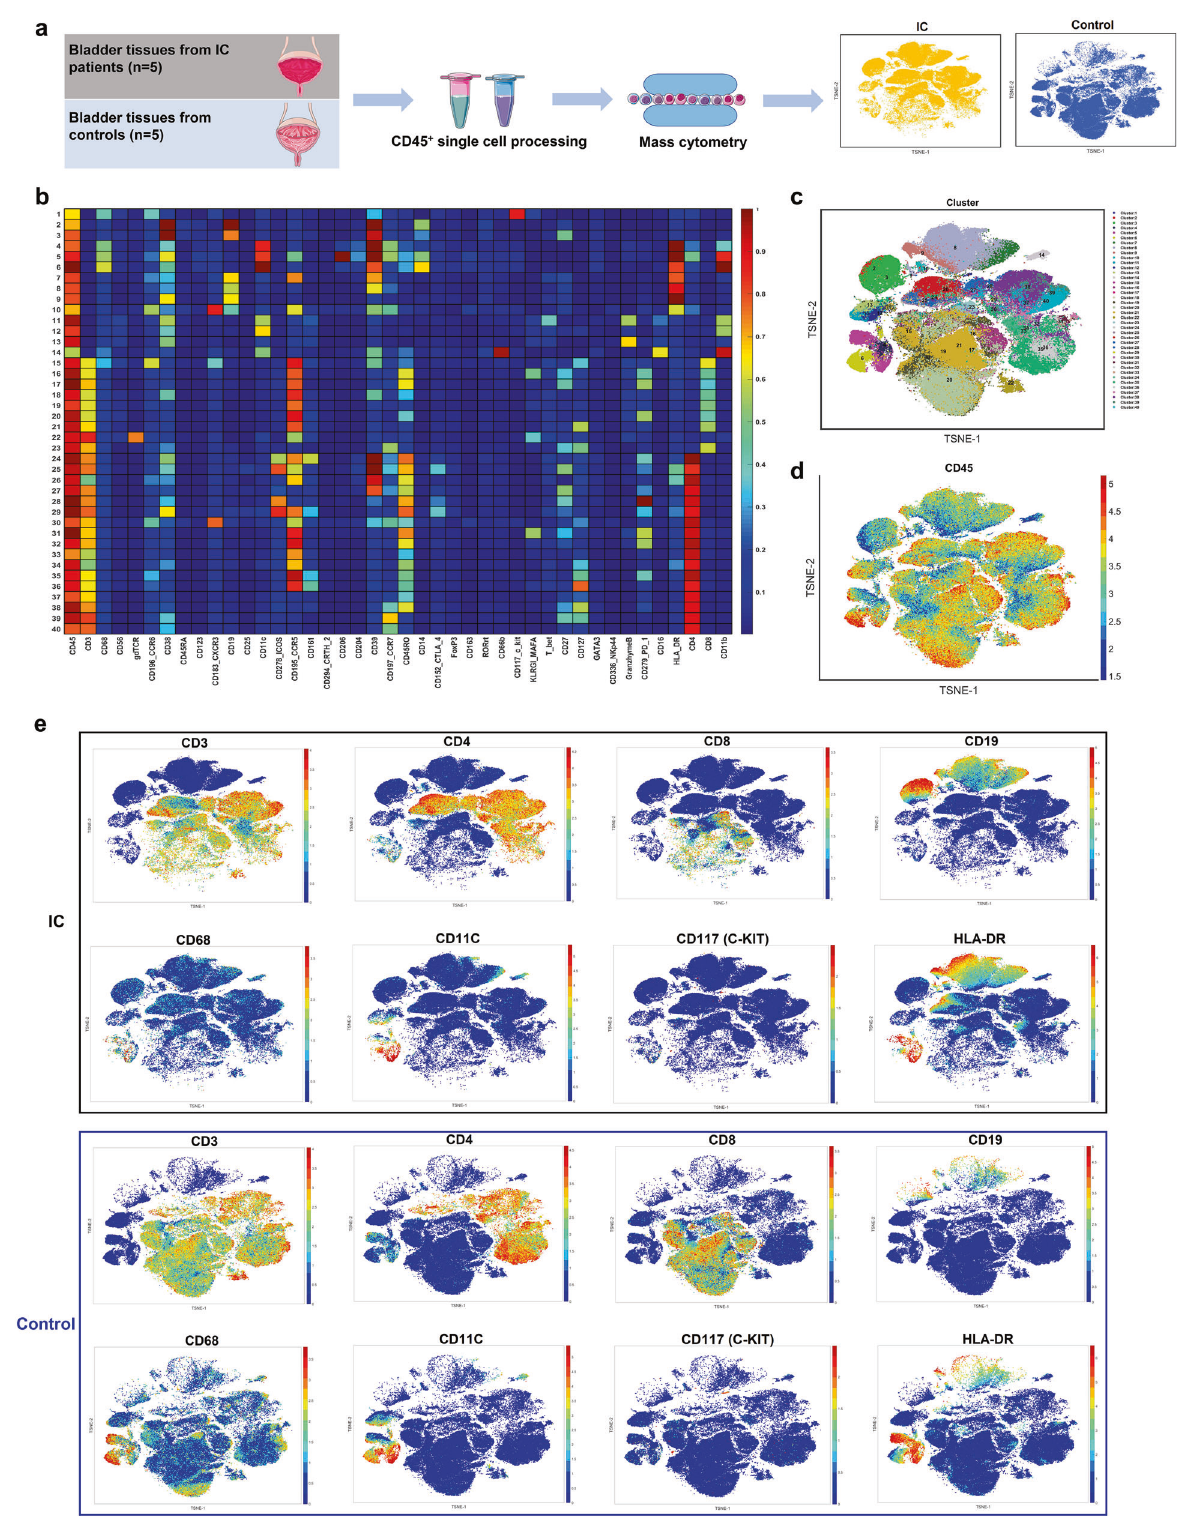
Fig. 4 Mass cytometry (CyTOF) con fi rmed the phenotypical heterogeneity of immune cells in IC bladders. a Overview of work fl ow for CyTOF (IC, n = 5; control, n = 5). b The heatmap showed the relative protein expression level of selected markers in bladder tissues, and generated clusters are visualized by T-SNE plots ( c ). d Feature plots showing the expression of the canonical marker gene (CD45) across immune cells. e The selected markers of T cell (CD3), CD4 + T cell (CD4), CD8 + T cells (CD8), B cell (CD19), macrophage (CD68), dendric cell (CD11C), mast cell (C-KIT), and activated gene (HLA-DR) were detected in the IC and control groups. IC interstitial cystitis